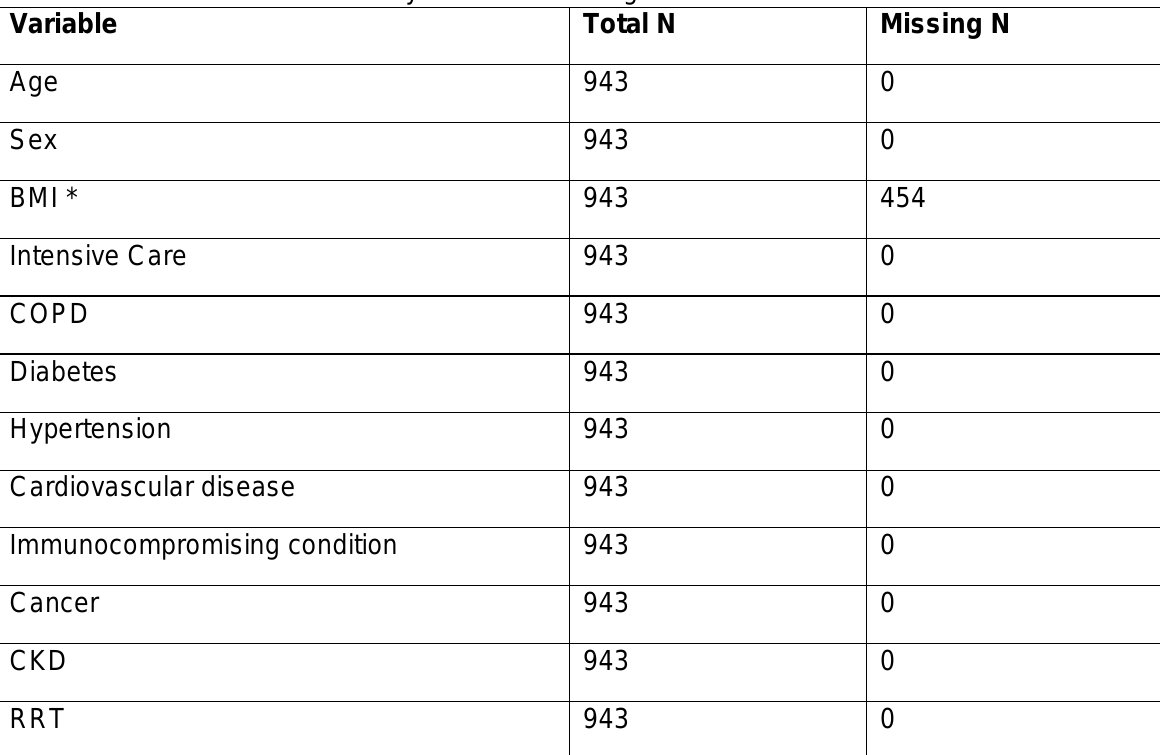
Supplemental table S1 Missing values. BMI denotes body mass index, COPD denotes chronic obstructive pulmonary disease; CKD denotes chronic kidney disease, RRT denotes. * BMI was not included in the analysis due to missing